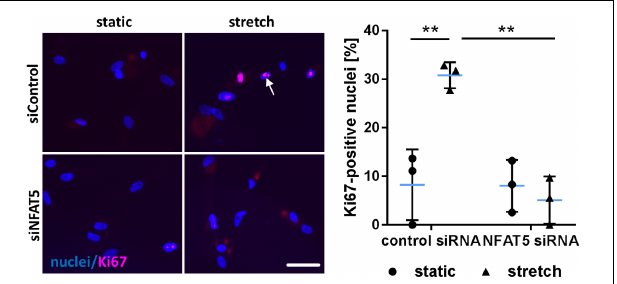
FIGURE 8 | Knockdown of NFAT5 inhibits stretch-induced proliferation of HUASMCs. HUASMCs were treated with NFAT5-specific or control siRNA and exposed to biomechanical stretch for 24 h. Proliferation was assessed by detecting the proliferation marker Ki67 via immunofluorescence techniques (arrow) and determining the percentage of Ki67-positive nuclei ( ∗∗ p < 0.01, one-way ANOVA and Tukey post-test, n = 3; scale bar: 50 µ